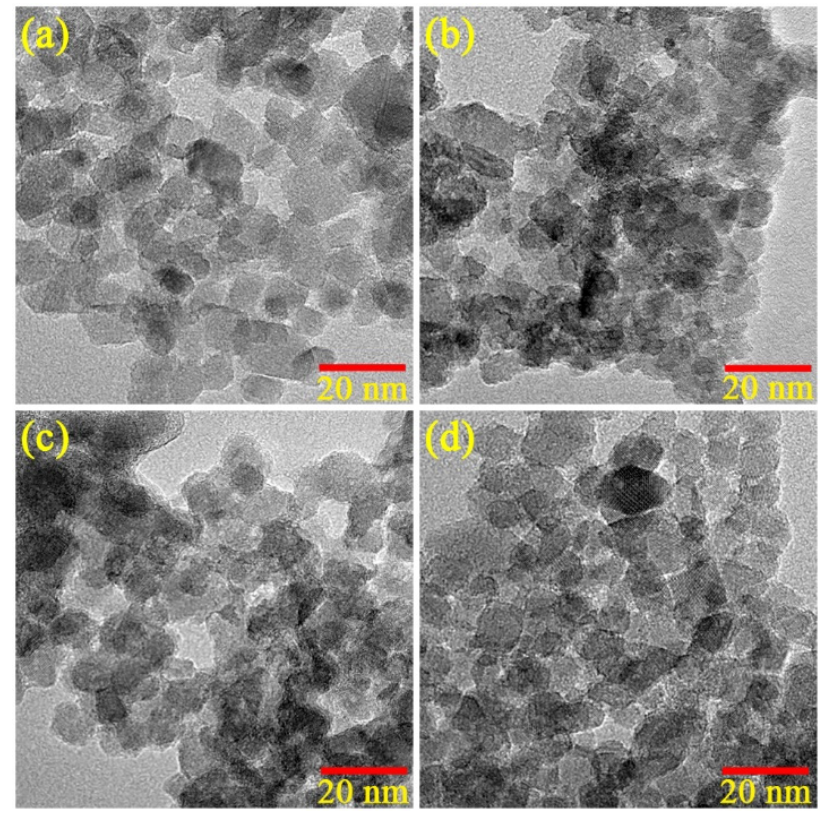
Figure 3. TEM images of ( a ) undoped, ( b ) 0.1 wt.%, ( c ) 0.5 wt.% and ( d ) 1.0 wt.% Cu-doped TiO 2 nanoparticles.